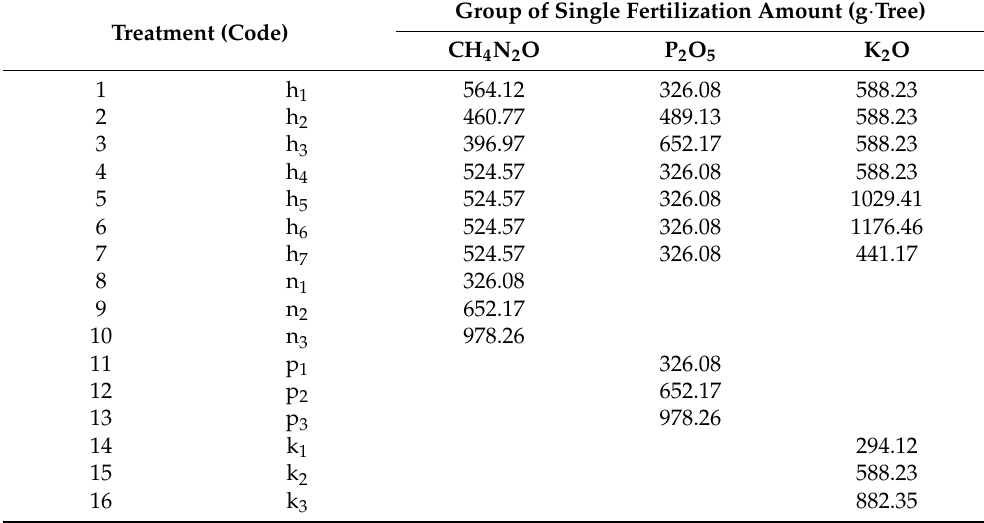
Table 1. Single-fertilization